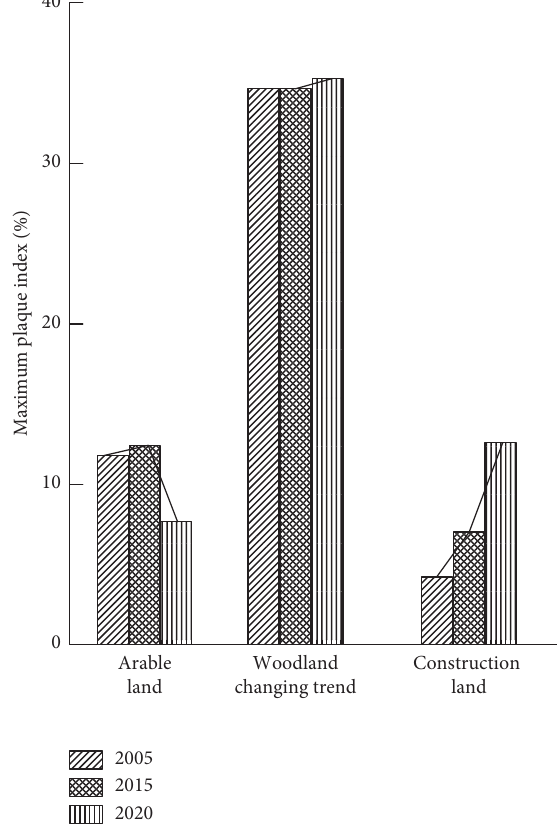
Figure 8: Trend chart of cultivated land, forest land, and con- struction